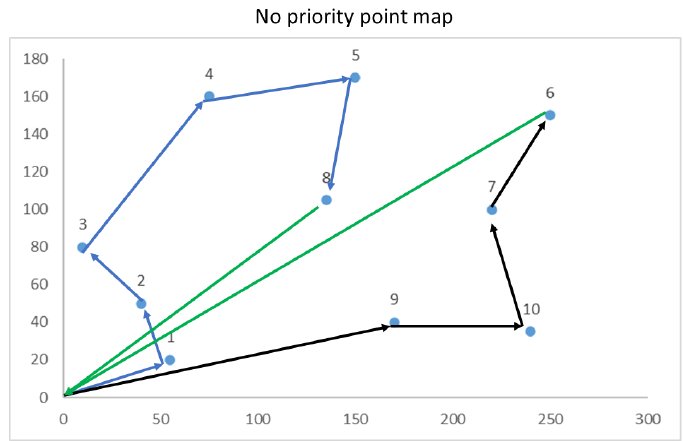
Figure 9. Route of points without priority (unit: meters).